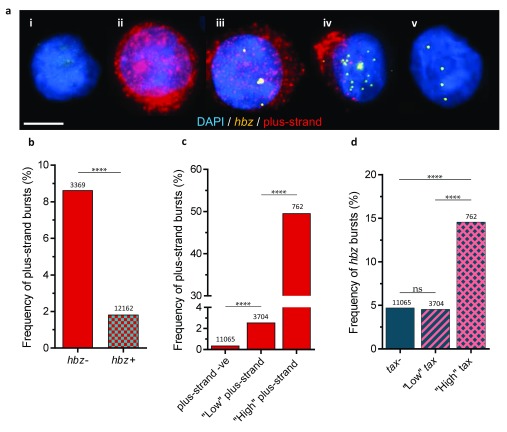
Relationship between expression of the plus-strand and
hbz in individual cells.
a. Representative images of a i) plus-strand
-silent cell, ii) plus-strand-high cell (≥100 spots) with a plus-strand burst, iii) plus-strand-high cell without a plus-strand burst (note the presence of an
hbz burst), iv) plus-strand-low cell (<100 spots) and v) plus-strand-silent cell, with low-level
hbz.
b. plus-strand bursts occur more frequently in
hbz-negative cells.
c. plus-strand bursts are indicative of very high plus-strand expression, with the proportion of cells which have a burst increasing as the level of plus-strand RNA increases.
d.
hbz bursts occur more frequently in high-plus-strand cells than in plus-strand-negative or plus-strand-low cells. Numbers above columns denote the number of cells in the corresponding population, from four pooled plus-strand-competent clones.